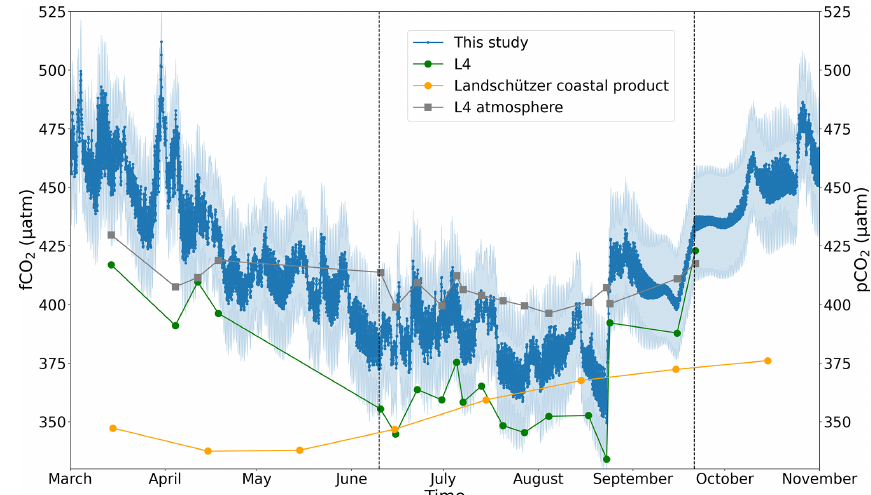
Figure 12. f CO 2 and p CO 2 values used to calculate the regional CO 2 flux over the domain (128km 2 , approximately same as in above figures). Measurements of f CO 2 made by RV Plymouth Quest on station at L4 (L4, green dots). p CO 2 ( atm ) measured by RV Plymouth Quest on station at L4 (grey squares). The results of this study; hourly average f CO 2 across the valid model domain used for long-term flux calculations (this study, blue dots). The standard combined uncertainty in the data from this study is indicated by the shaded background in light blue. The monthly Landschützer p CO 2 data (Landschützer coastal product, orange dots) are from the closest valid node (50.125 ◦ N, 4.125 ◦ W) in the Landschützer et al. (2020) coastal data product. It is noted that the Landschützer node is outside of the model domain (which has a lower boundary of 50.24 ◦ N). The vertical dashed lines indicate the dates of the first and last measurement